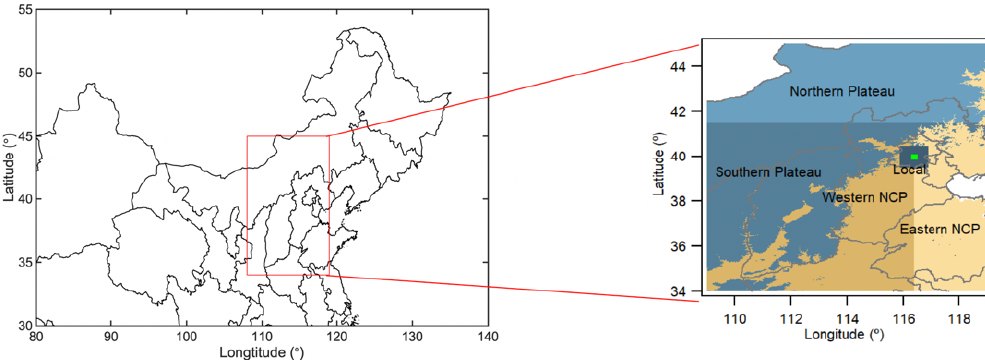
Figure 1. Classification of air mass sources (modified from Liu et al.,